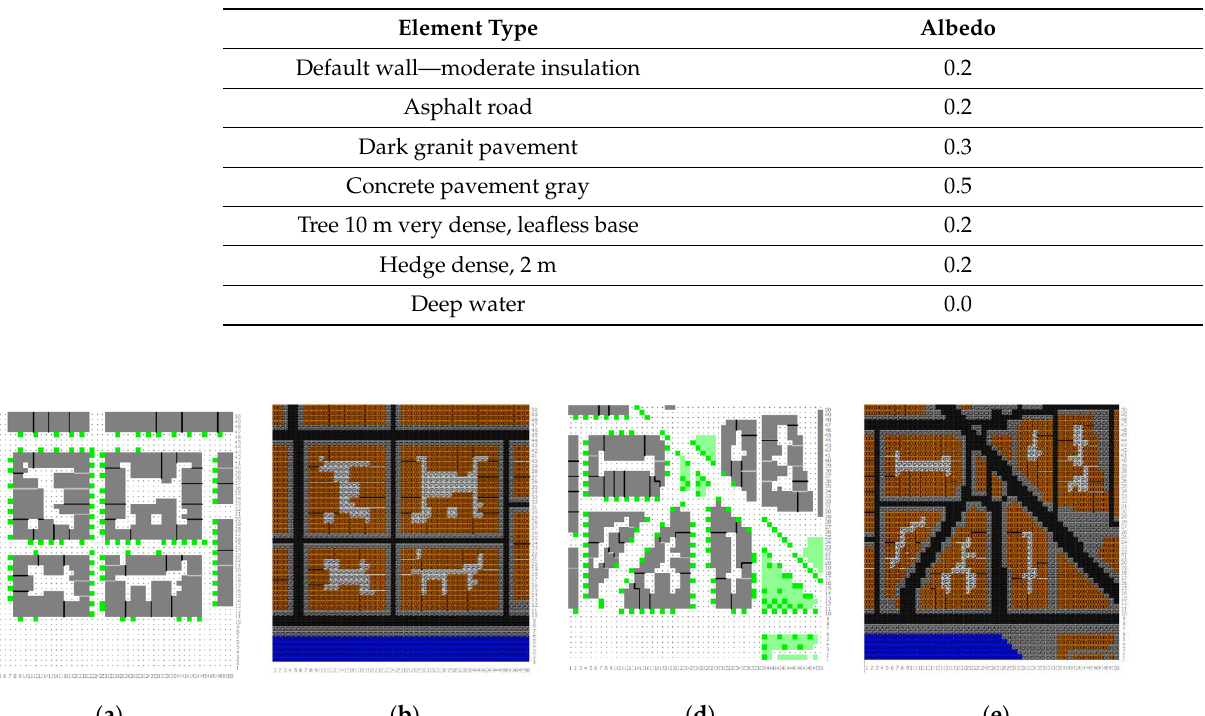
Table 4. Element types used in ENVI-met© software and Albedo.